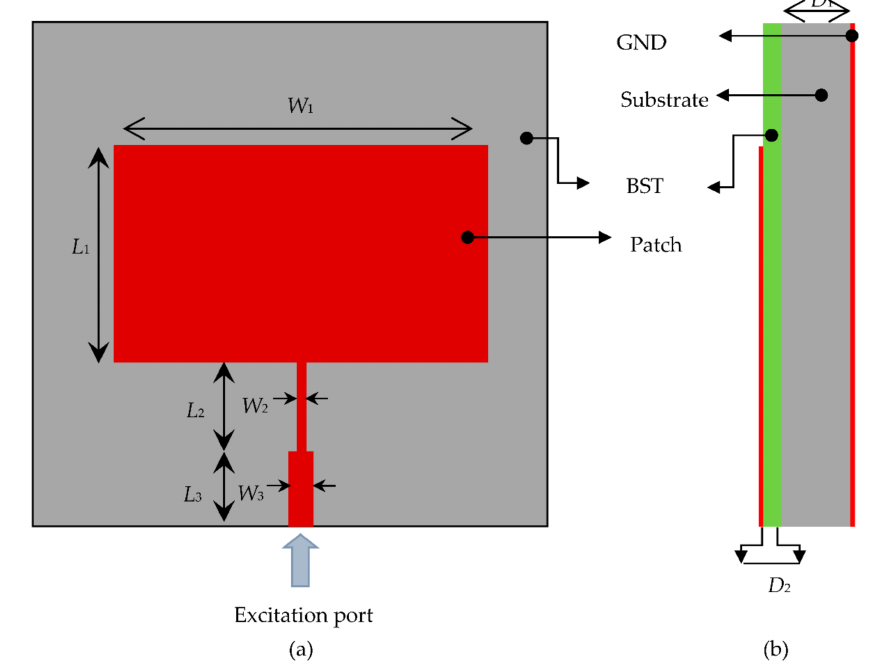
Figure 3. Proposed microstrip patch antenna ( a ) directly on top and ( b ) side